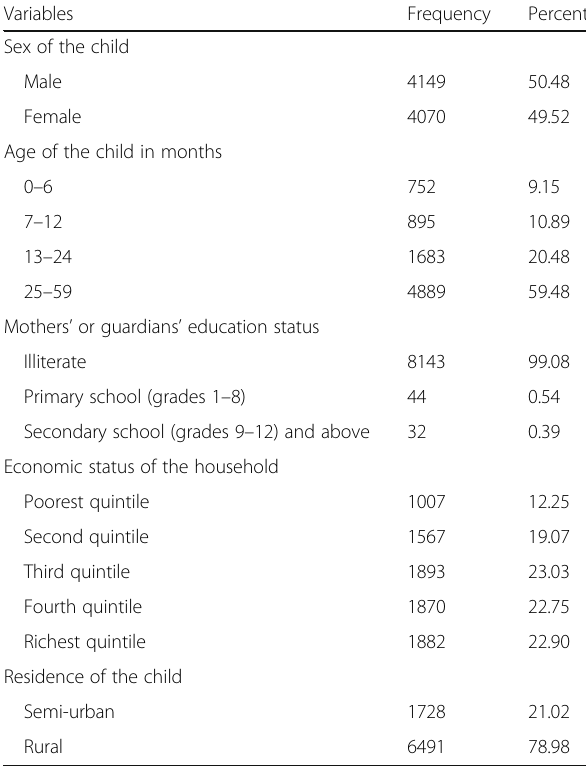
Table 1 Demographic information of under-five children